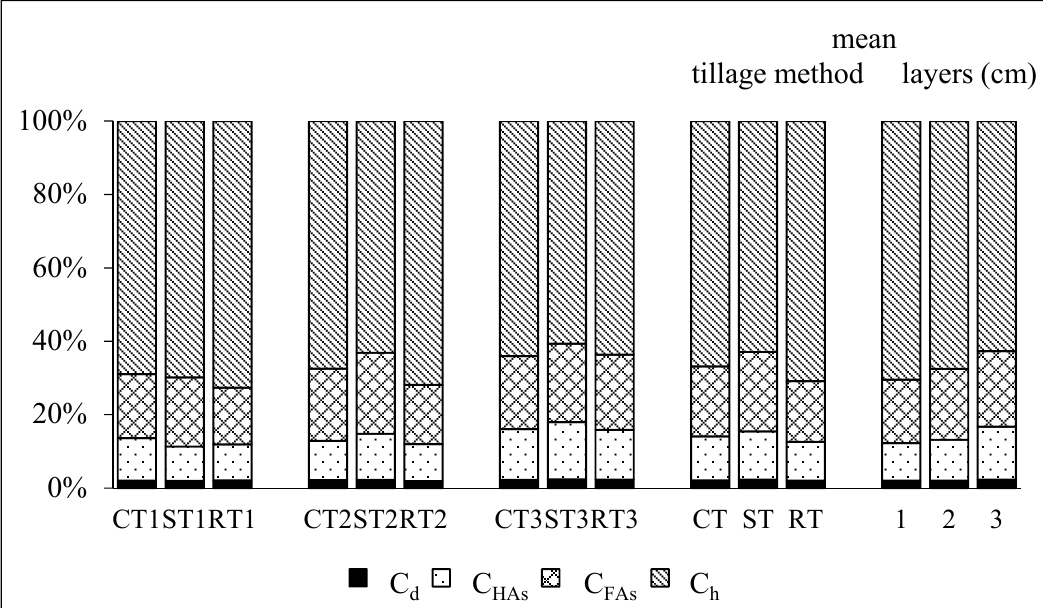
Figure 3. Share of carbon in organic matter fractions and average values for factors (LSD for: C d —factor I, 0.14 and factor II, 0.08; interaction—I/II, 0.18 and II/I, 0.14; C HAs —factor I, 0.59 and factor II, 1.14; interaction—I/II, 1.72 and II/I, 1.98; C FAs —factor I, 0.33 and factor II, 0.94; interaction—I/II, 1.37 and II/I, 1.63; C h —factor I, 1.28 and factor II, 1.36; interaction—I/II, 2.17 and II/I, 2.10.